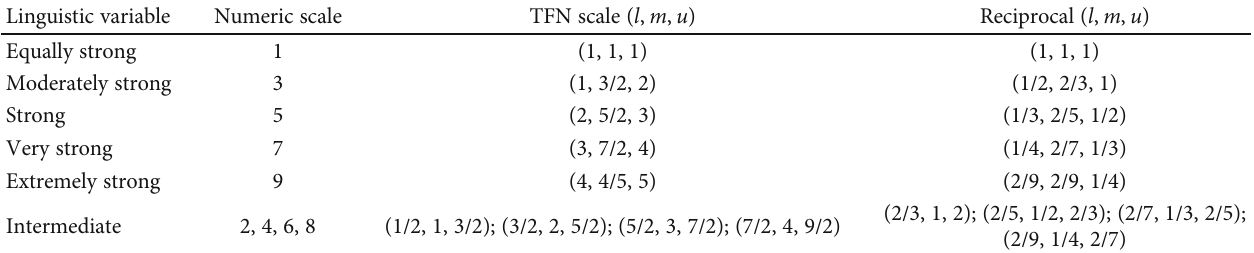
Table 8: Triangular fuzzy